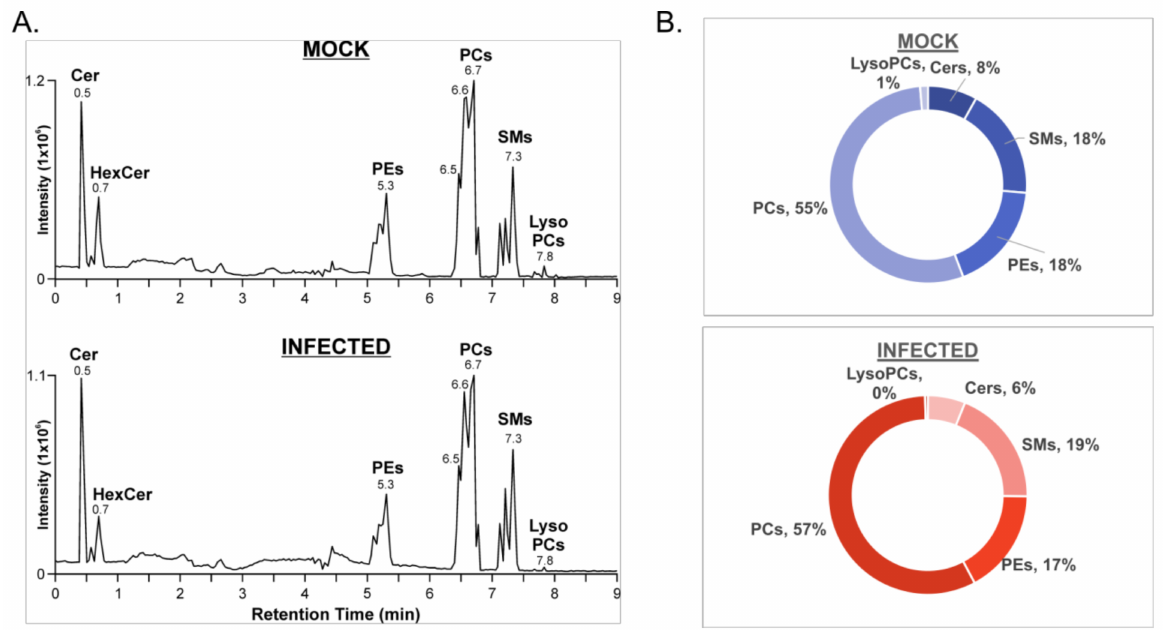
Figure 2. Lipid identification from the positive ionization mode data set for mock- and VSV-infected cells. ( A ) Ion mobility extracted ion chromatograms of mock- and VSV-infected cells from positive ionization mode; ( B ) Proportions of major lipid classes identified in positive ionization mode from mock- and VSV-infected cells determined by manual integration of chromatographic peak